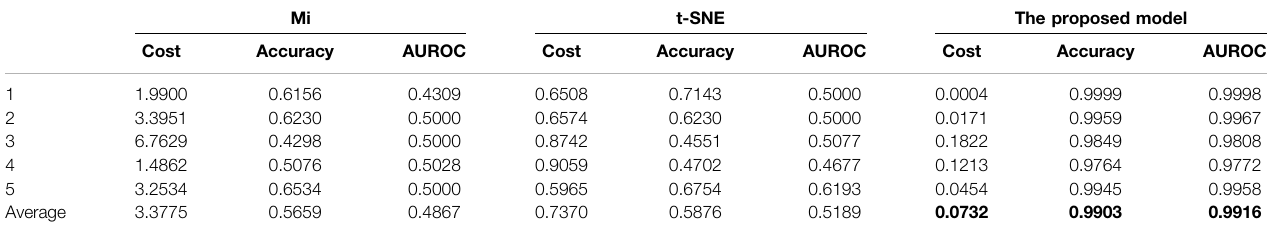
TABLE 5 | 5-fold performance comparison of different feature selection algorithms in the deep learning-based prediction model.